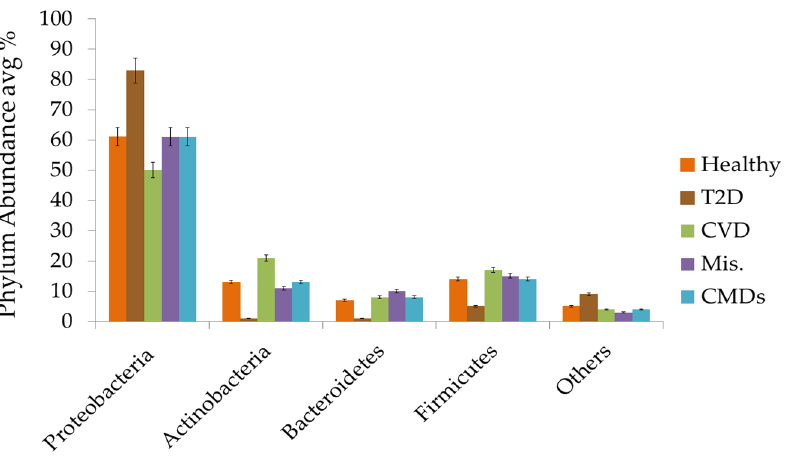
Figure 3. Average abundance of different phylum in healthy, T2D, CVDs, Mis., and overall in CMDs.